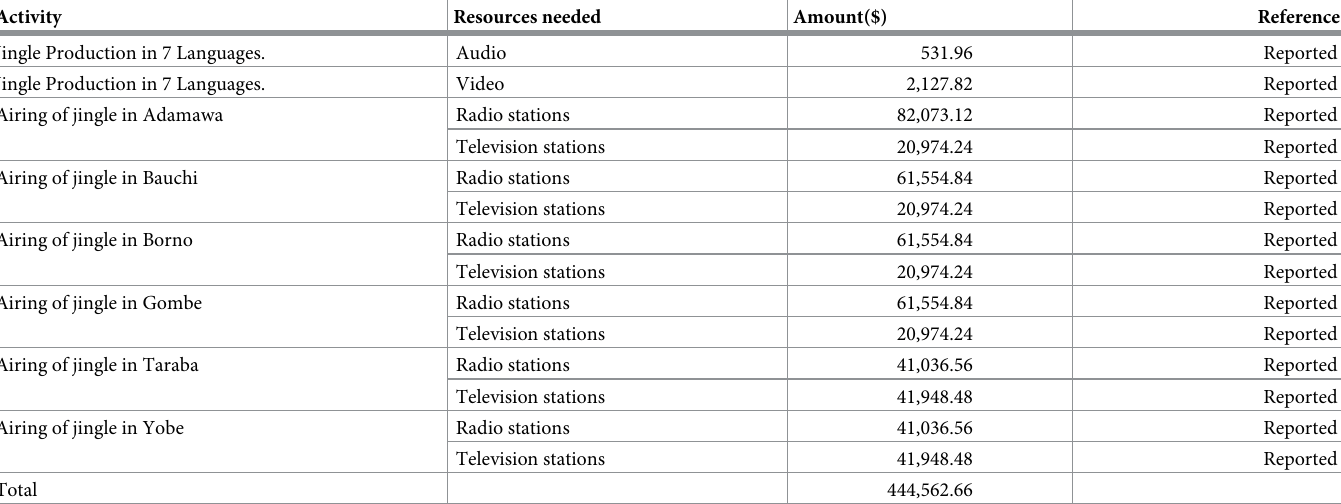
Table 6. Estimation of cost of public health awareness on snakebite in 6 states of North East (NE) Nigeria using Broadcasting media. Activity